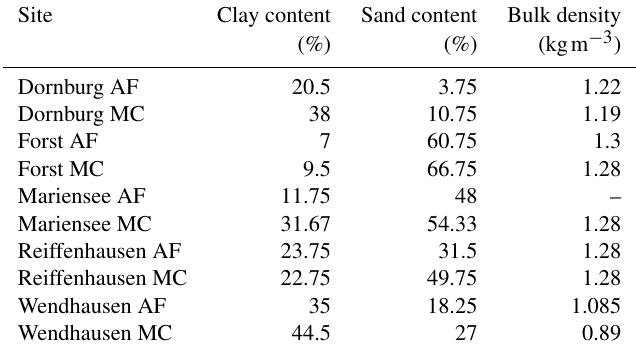
Table B2. Site-specific soil characteristics, with the soil texture being representative for the top soil column of 0.3m. The bulk density is representative for the top soil column of 0.05m. Data provided by Göbel et al. (2018) and Marcus Schmidt (personal communication, Georg August University of Göttingen, Buesgen Institute, Soil Science of Tropical and Subtropical Ecosystems,